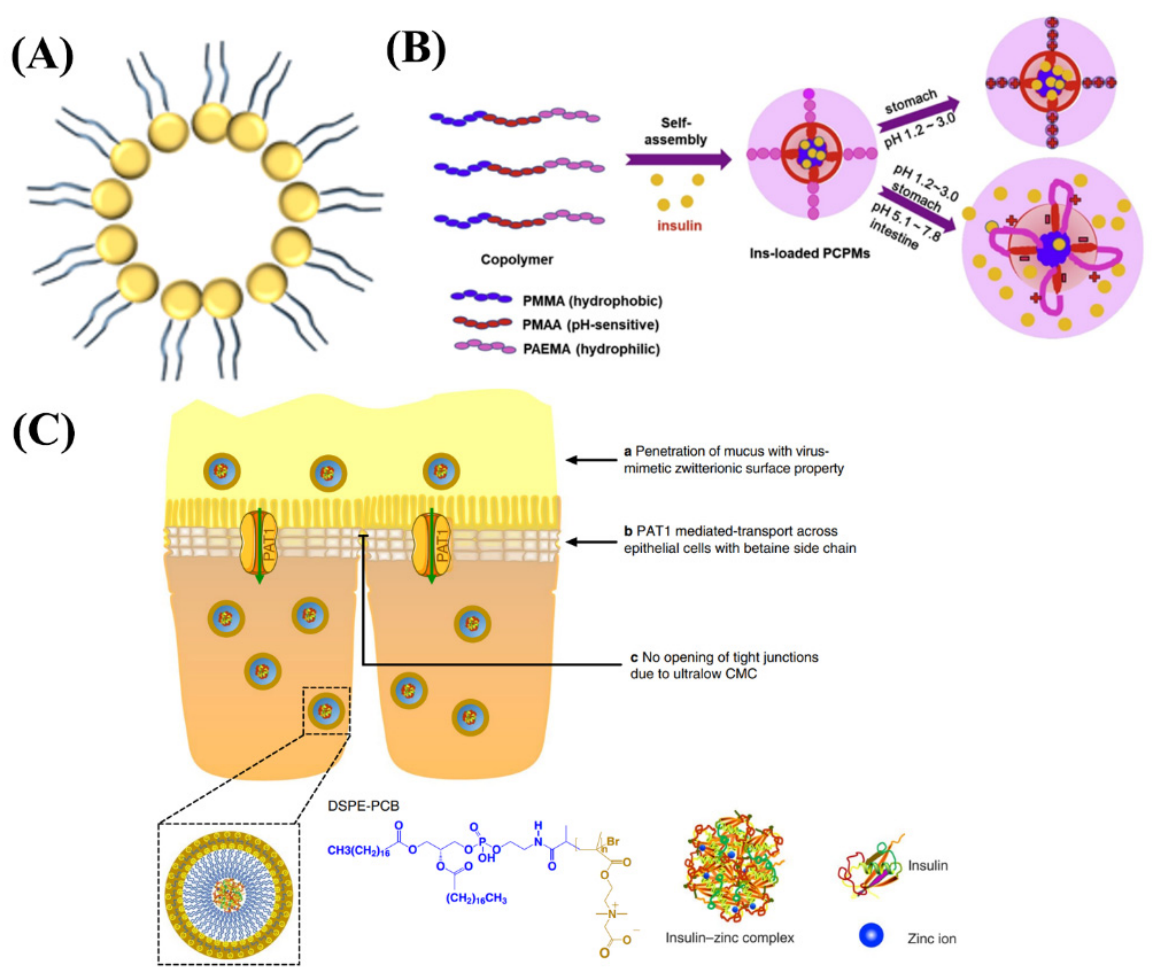
Figure 4. ( A ) Structure of micelles. ( B ) Schematic representation of Ins-loaded PCPMs and its pH- triggered release. ( C ) Schematic representation of DSPE-PCB micelles for oral delivery of